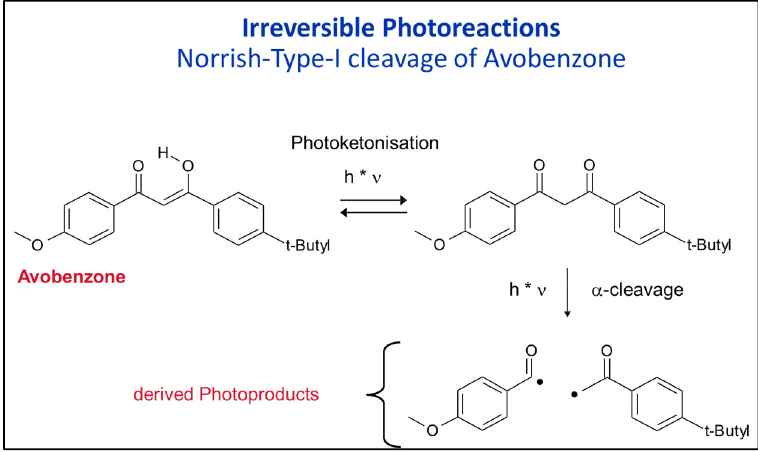
Figure 2. Irreversible photoreactions of Avobenzone [27].